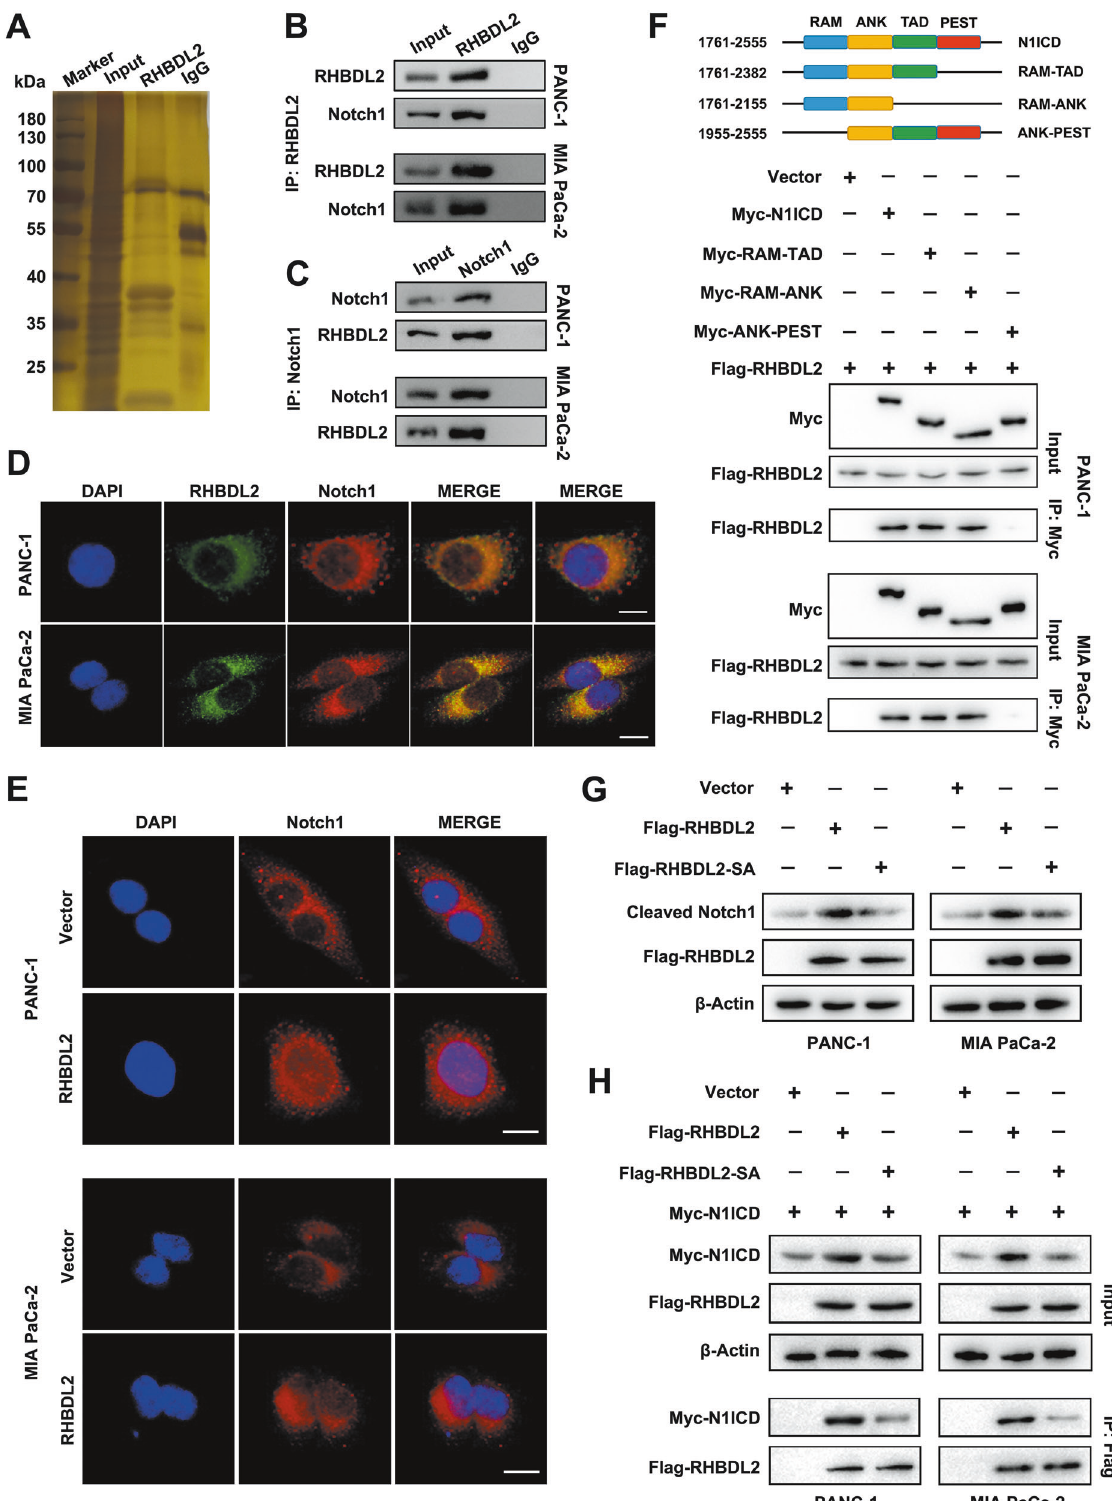
Fig. 4 RHBDL2 interacts with Notch1 and mediates the cleavage of Notch 1 and release of Notch1 intracellular domain (N1ICD). A Silver staining assay was performed to detect the differential protein bands. B , C Immunoprecipitation (IP) assay of RHBDL2 and Notch1 in PC cells. Immuno fl uorescent (IF) staining assay presented the co-localization of RHBDL2 and Notch1 ( D ) and the distribution of Notch1 ( E ), respectively. Scale bar: 10 μ m. F N1ICD ’ s domain organization and N1ICD truncations ’ scheme, followed by IP assay. G The level of cleaved Notch1 was determined by Western blot assay. H IP assay detected the N1ICD level in the indicated PC cells. Flag-RHBDL2: RHBDL2 wild-type group; Flag- RHBDL2-SA: a serine to alanine (SA) catalytic mutant of RHBDL2.